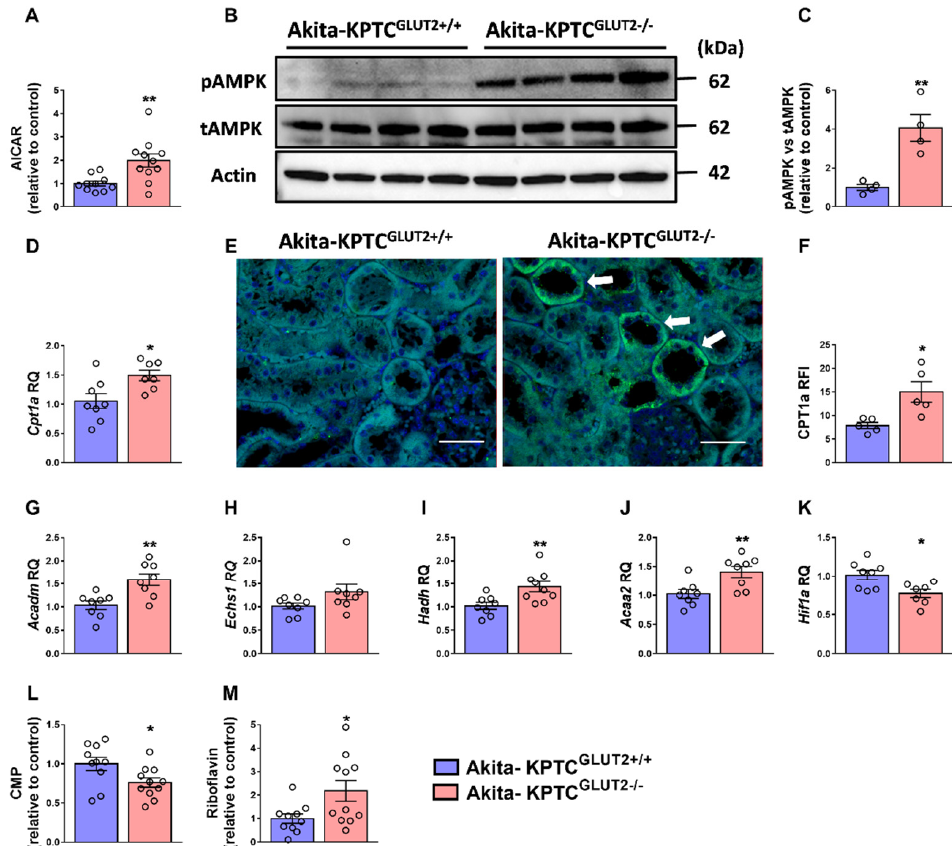
Figure 3. AICAR activates AMPK and restores fat oxidation in KPTC-GLUT2 null Akita diabetic mice. Significant AICAR upregulation in Akita-KPTC GLUT2-/- mice (n = 11), compared with Akita- KPTC GLUT2+/+ mice (n = 10) ( A ), was associated with the elevated protein expression levels of pAMPK, shown in a representative immunoblot ( B ) and quantification (n = 4 mice for each group) ( C ). A significant increase in the fatty acid β -oxidation rate-limiting enzyme Cpt1a at the mRNA (n = 8 for Akita-KPTC GLUT2+/+ , n = 7 for Akita-KPTC GLUT2 − / − ) ( D ) and protein levels shown in a representative IF (20 × magnification, scale bar: 50 µ m) ( E ) and quantification (n = 5 mice for each group) ( F ). The mRNA expression levels of β -oxidation enzymes (n = 8 mice for each group) ( G – J ). Significant decreases in the expression of Hif1a ( K ), and the levels of CMP ( L ) and increased riboflavin ( M ) metabolite levels (n = 10 for Akita-KPTC GLUT2+/+ , n = 11 for Akita-KPTC GLUT2 − / − ). The data represent the mean ± SEM and were analyzed by Unpaired Two-tailed Student’s t-test; Nonparametric Mann–Whitney test was used for unnormal distributed data. * p < 0.05, ** p < 0.01.